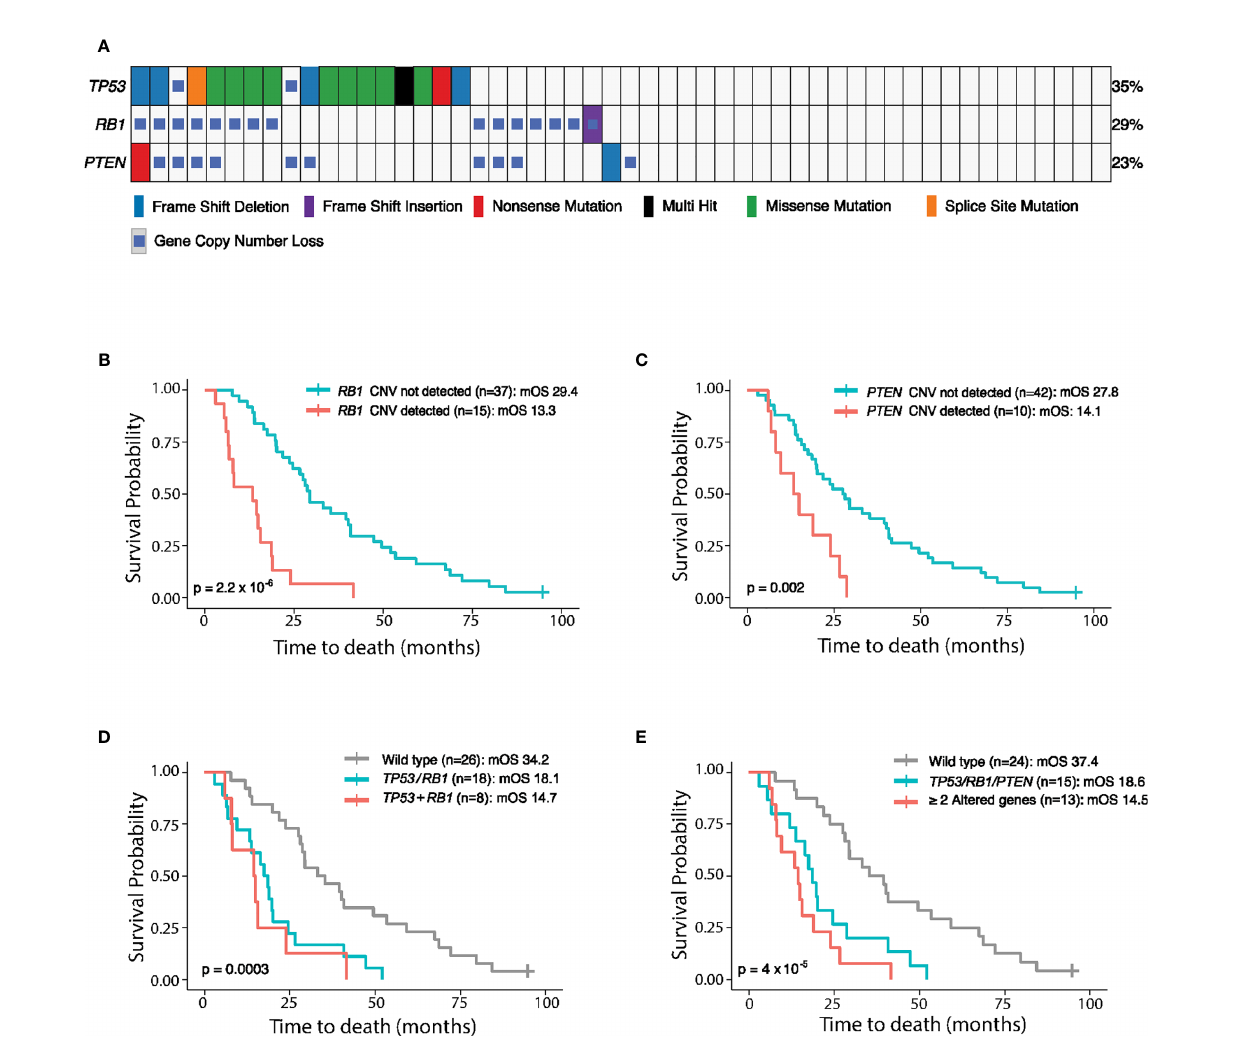
FIGURE 2 | Genomic alterations of TP53 , RB1 , and PTEN detected in 52 mCRPC plasma samples collected at the Mayo Clinic and their association with patient outcome. (A) Genomic landscape of PTEN , RB1 , and TP53 in 52 mCRPC patients, including copy number variations (CNVs), single nucleotide variations (SNVs), and short insertions/deletions, reported by the cfDNA-based PredicineCARE assay. Blood samples were collected from patients before chemotherapy treatment. The percentage of samples having aberrations (SNV + CNV) in each gene is listed to the right of the heatmap. (B – E) Kaplan-Meier analysis of overall survival (OS) according to PTEN , RB1 , and TP53 loss status. OS is plotted for different patient groups classi fi ed according to (B) RB1 copy loss status, (C) PTEN copy loss status, (D) alterations (SNV and/or CNV) in TP53 and/or RB1 , and (E) alterations (SNV and/or CNV) in one vs . more than one of the PTEN , RB1 , and TP53 genes. mOS, median overall survival. TP53/RB1 : either TP53 or RB1 was aberrant. TP53+RB1 : both TP53 and RB1 were aberrant. TP53/RB1/PTEN : any one of TP53 , RB1 , or PTEN was aberrant. ≥ 2 Altered Genes: at least two genes among the TP53 , RB1 , or PTEN triad harbored genomic